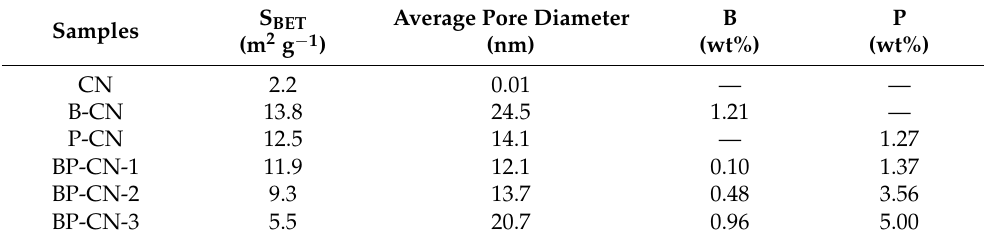
Table 1. S BET , BJH average pore diameter and B, P mass fraction of catalysts.